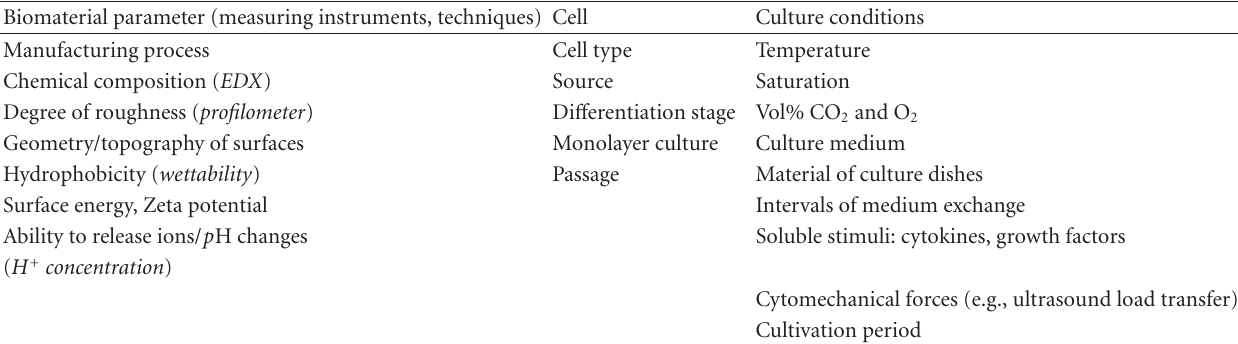
Table 1: Major parameters which influence the outcome in cytocompatibility testing of a